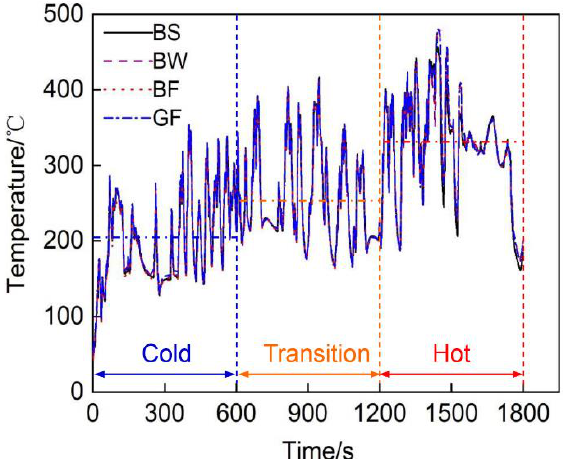
Figure 3. Temperature at the T1 measurement point of the exhaust pipes with different covering schemes over time.